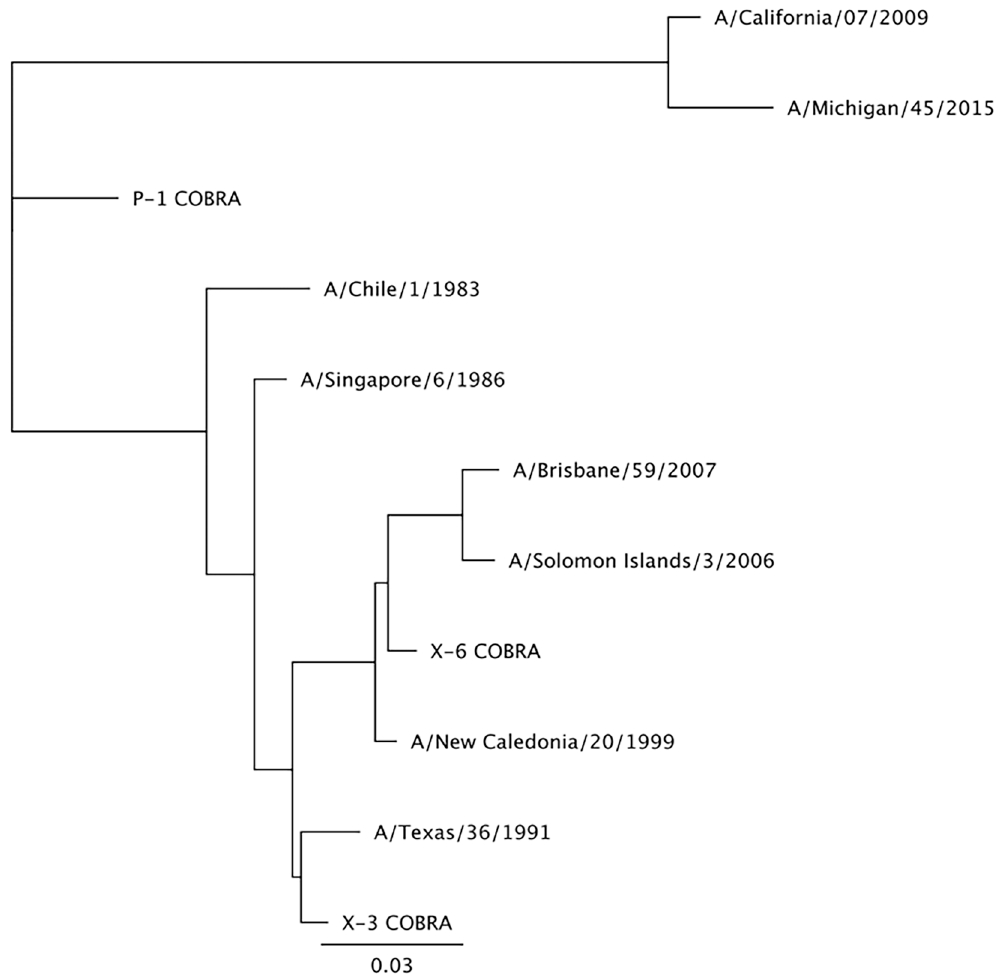
Fig 5. Phylogenetic tree of H1 HA sequences. The unrooted phylogenetic tree was inferred from HA amino acid sequences derived from 11 H1 HA isolates and COBRA HA using the maximum likelihood method. Sequences were aligned with MUSCLE 3.7 software, and the alignment was refined by Gblocks 0.91b software. Phylogeny was determined using the maximum likelihood method with PhyML software. Trees were rendered using TreeDyn 198.3 software